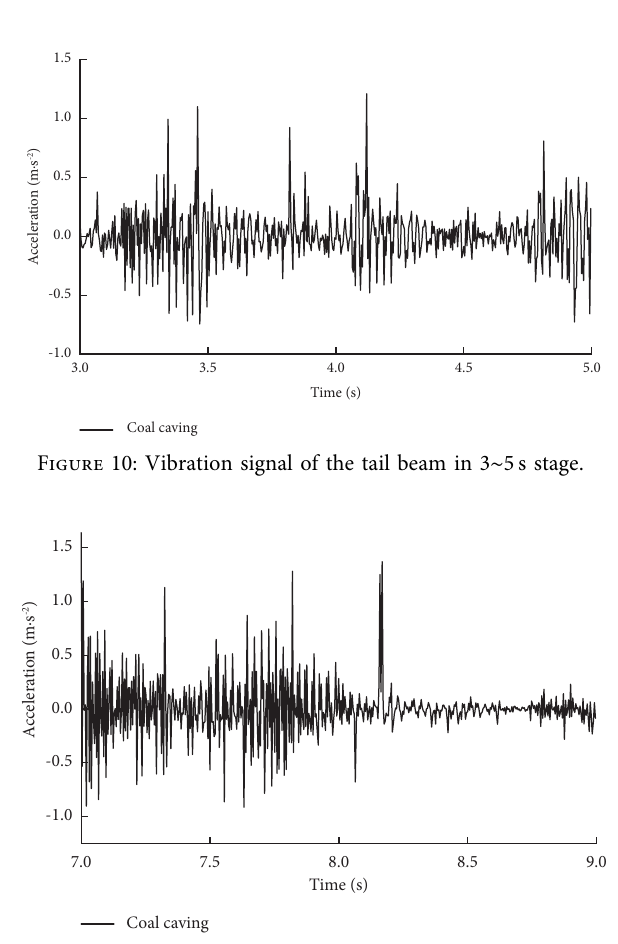
Figure 11: Vibration signal of the tail beam in 7 ∼ 9s stage.